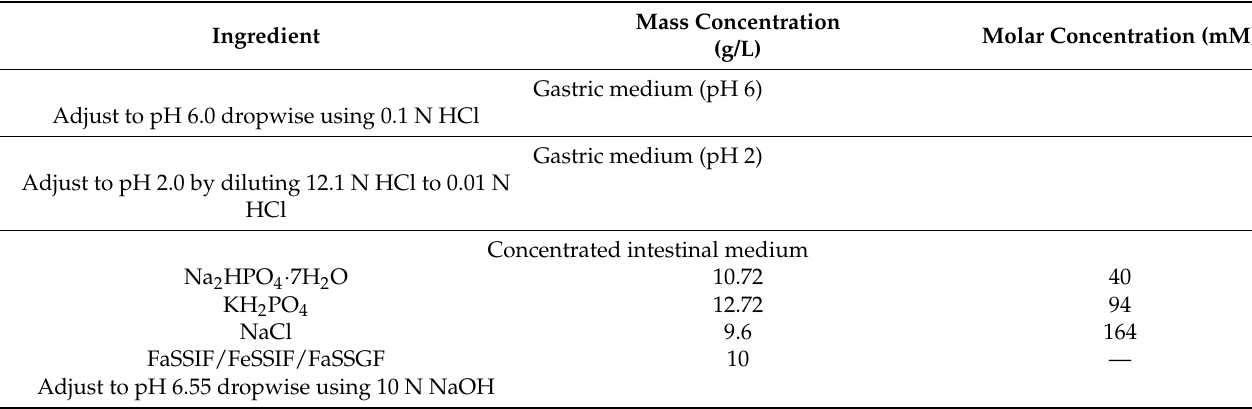
Table A4. Simulated gastric and concentrated intestinal media compositions used in USP 2 transfer dissolution testing of dosage forms.